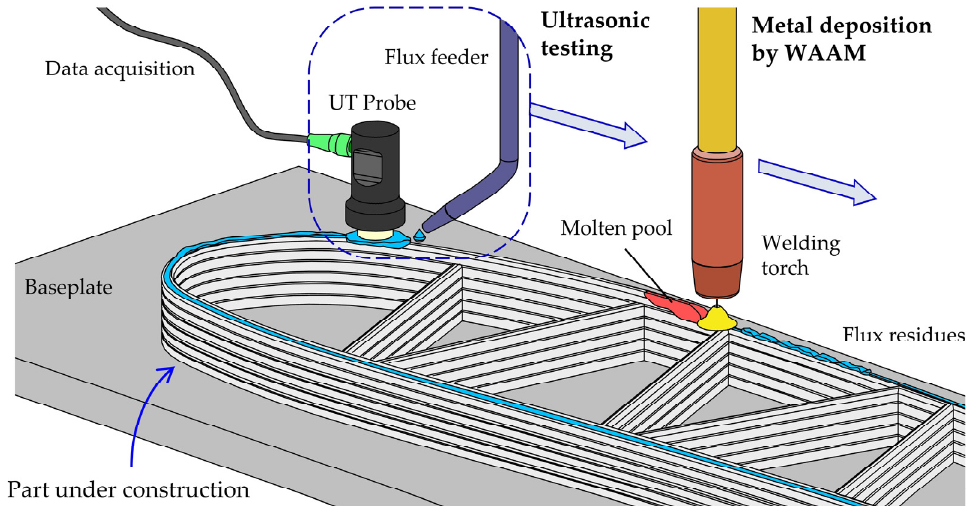
Figure 1. Schematic representation of in situ ultrasonic testing (UT) in wire arc additive manufacturing (WAAM).